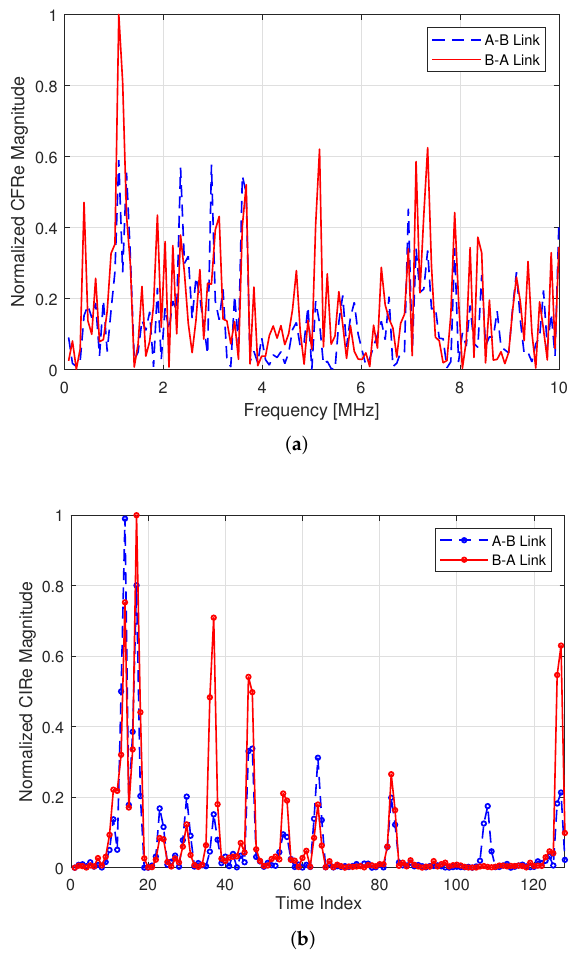
Figure 1. Example of a power line communication (PLC) channel frequency response estimation (CFRe) in both directions and in the frequency ( a ) and time ( b )